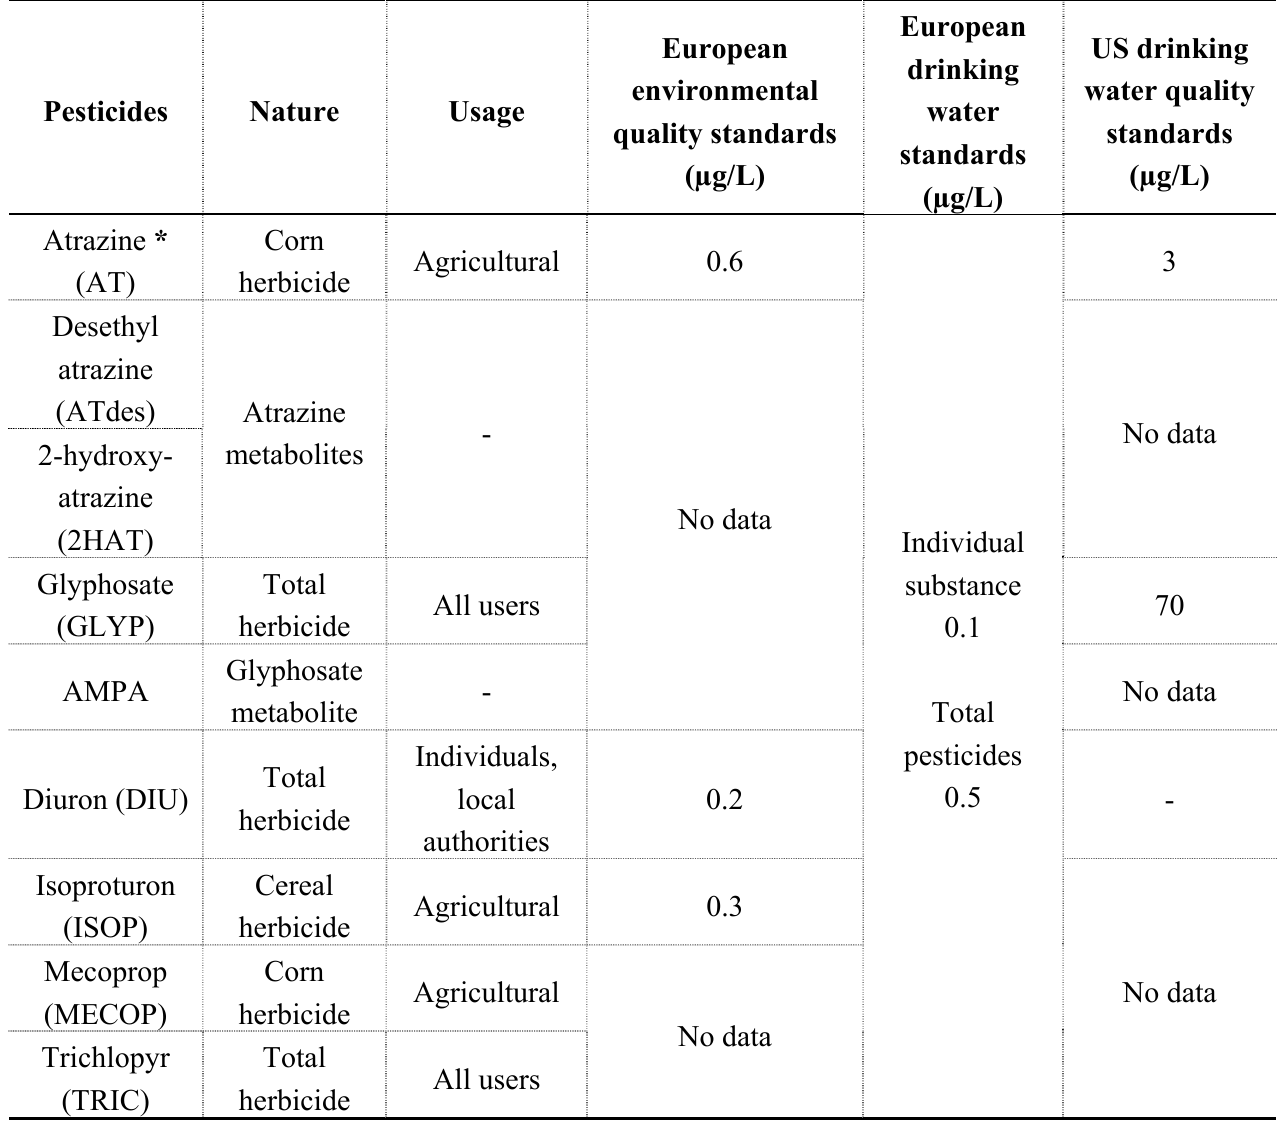
Table 3. Pesticides of interest, their usage and quality